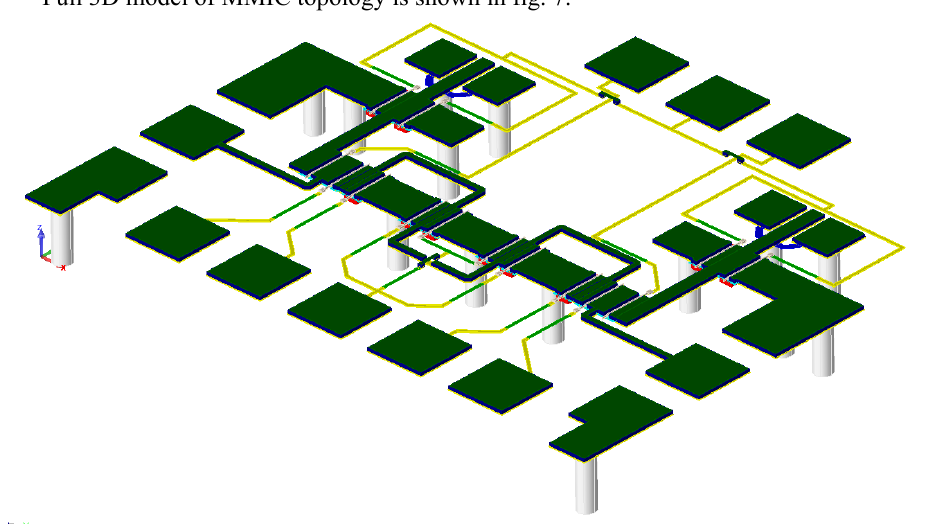
Fig. 7. Full 3D model of MMIC’s topology.